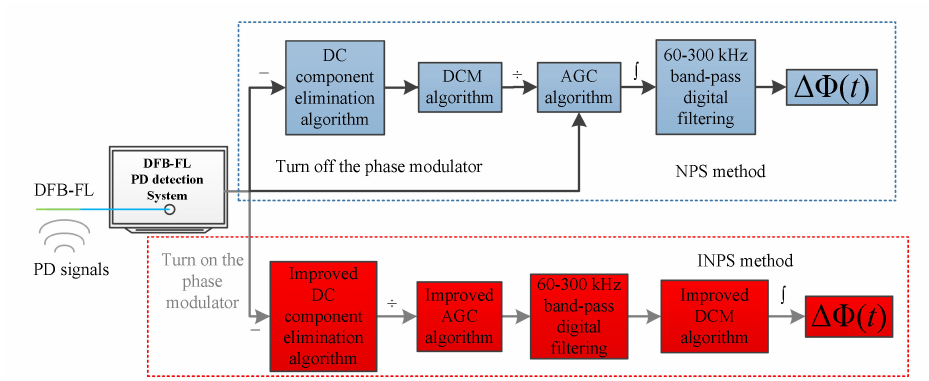
Figure 2. The flow chart of NPS and INPS. (The upper section shows the flow chart of NPS, the bottom shows the flow chart of